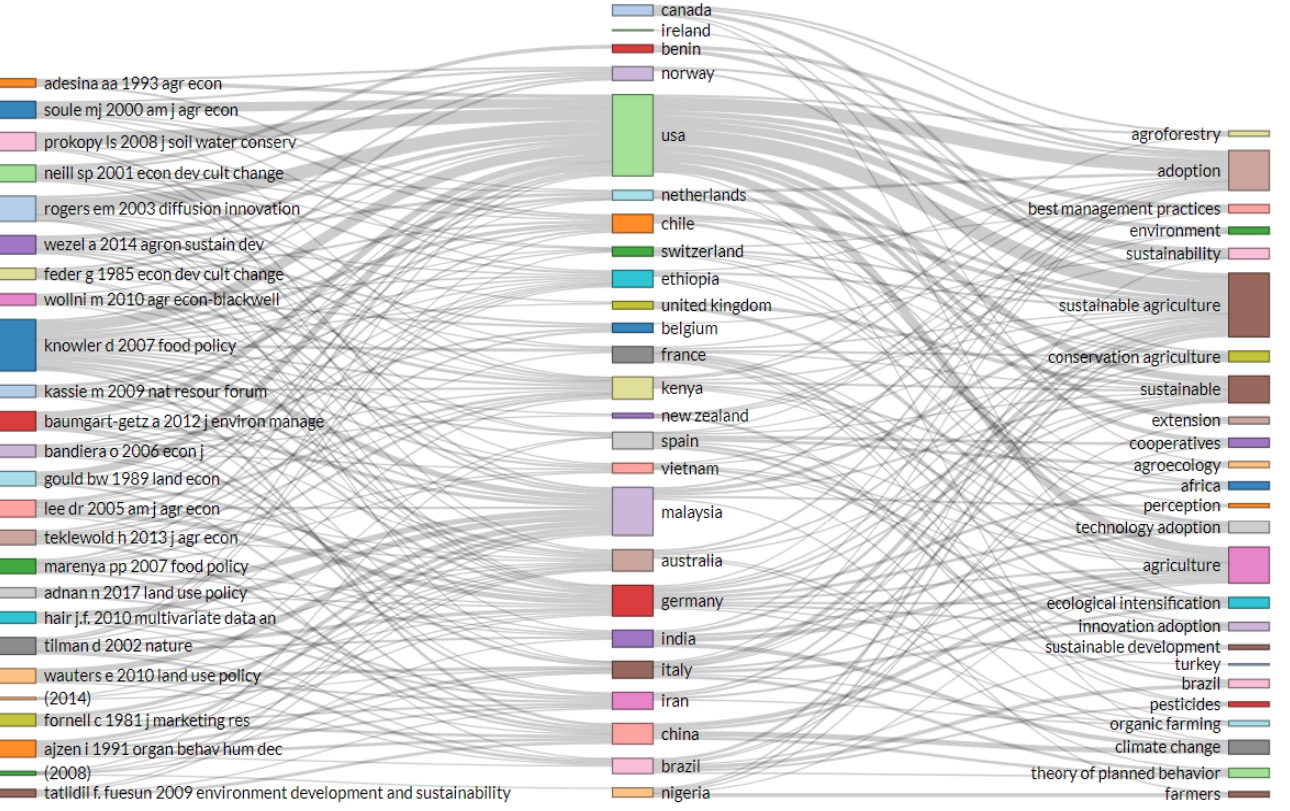
Figure 2. Three-field plots depicting the top 25 authors, countries, and keywords. Note: The figure was generated using R Studio software (Bibliometrix tool) with the bibliographic coupling method [53] analyzing data from WoS and Scopus.